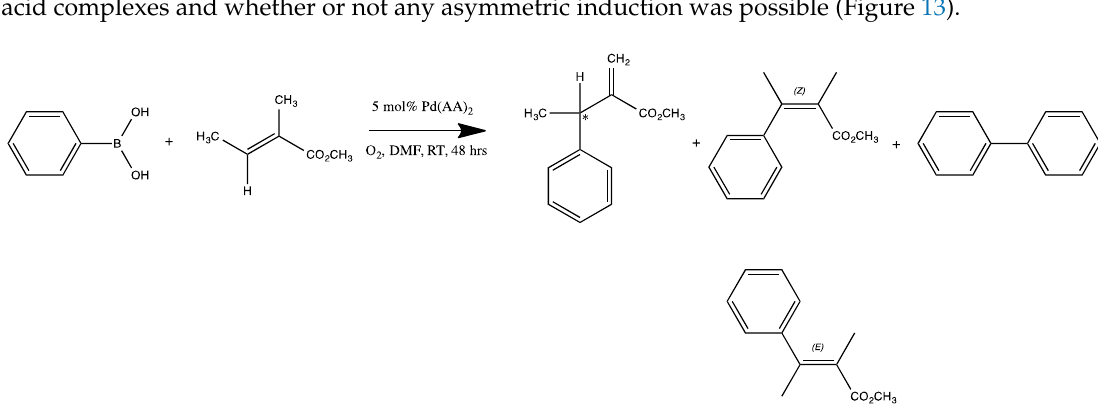
Figure 13. Bis(amino acid)Pd(II) catalyzed cross-coupling of phenylboronic acid and methyl tiglate.